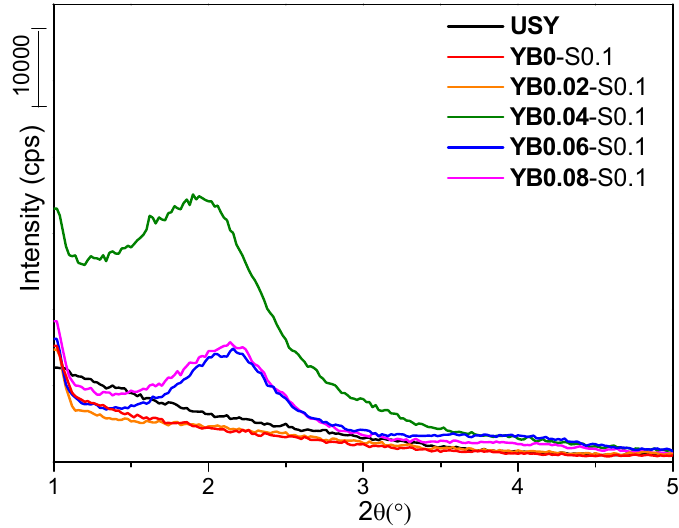
Figure 7. X-ray diffractograms at small angles of the modified zeolites produced using different base concentrations.